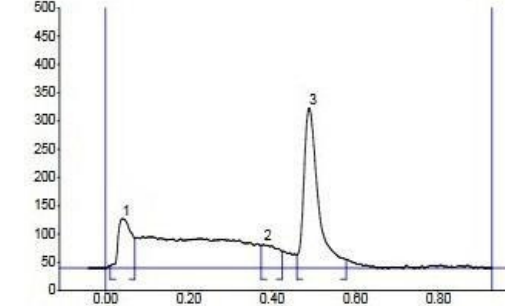
Fig. 15. Maceration fruit extract, HPTLC chromatogram of ethyl acetate fruit extract of M. cymbalaria Table 2. HPTLC analysis of macerated hexane fruit extract Peak